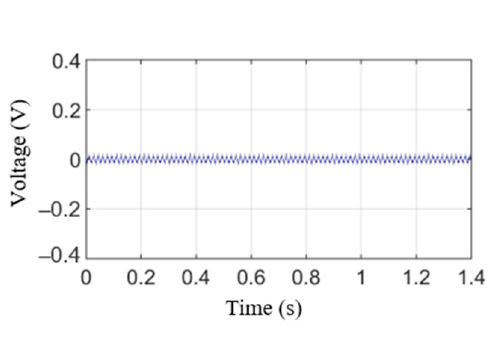
Figure 9. AE raw signal without press process.